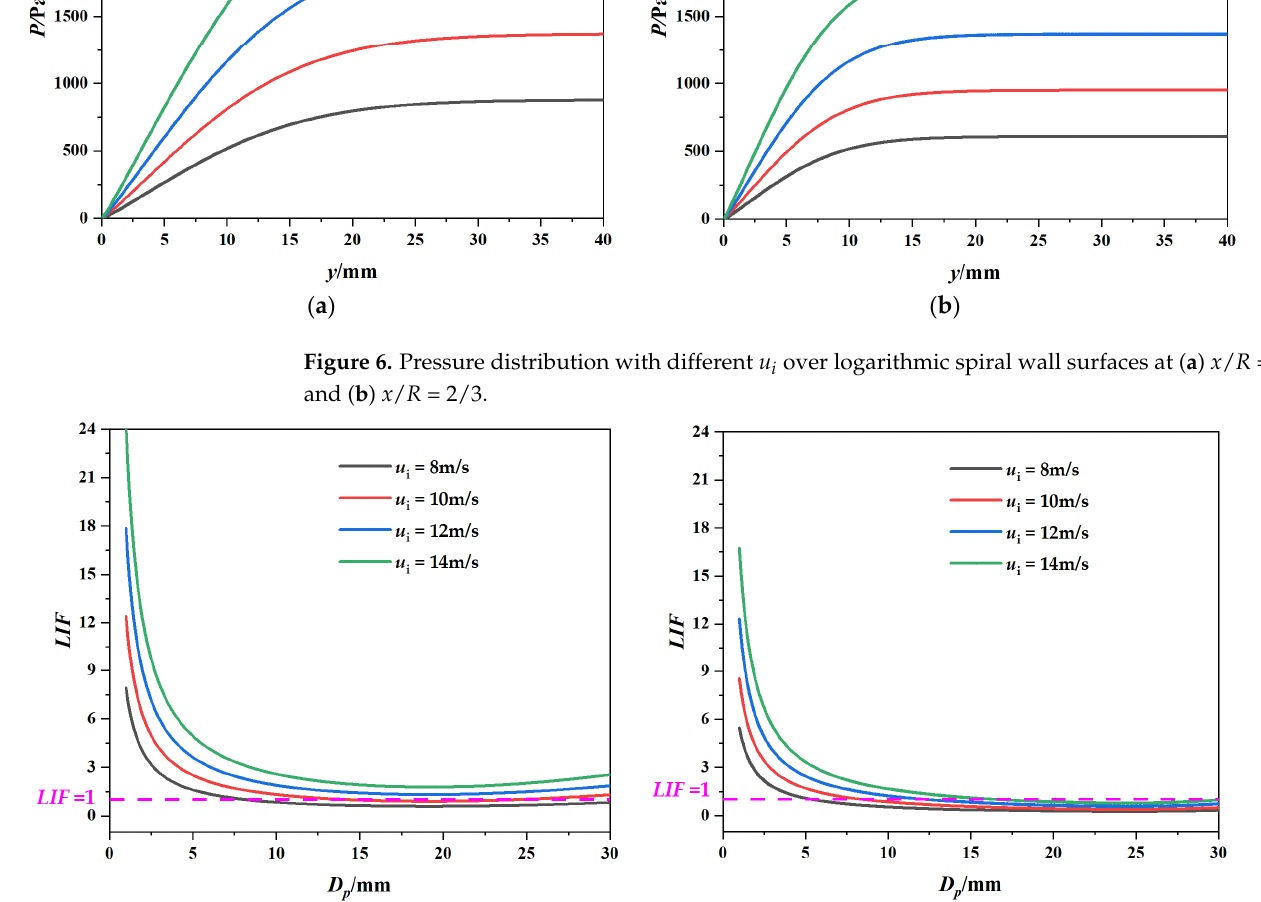
Figure 7. Lift index with different u i over logarithmic spiral wall surfaces at ( a ) x / R = 1 and ( b ) x / R = 2/3.